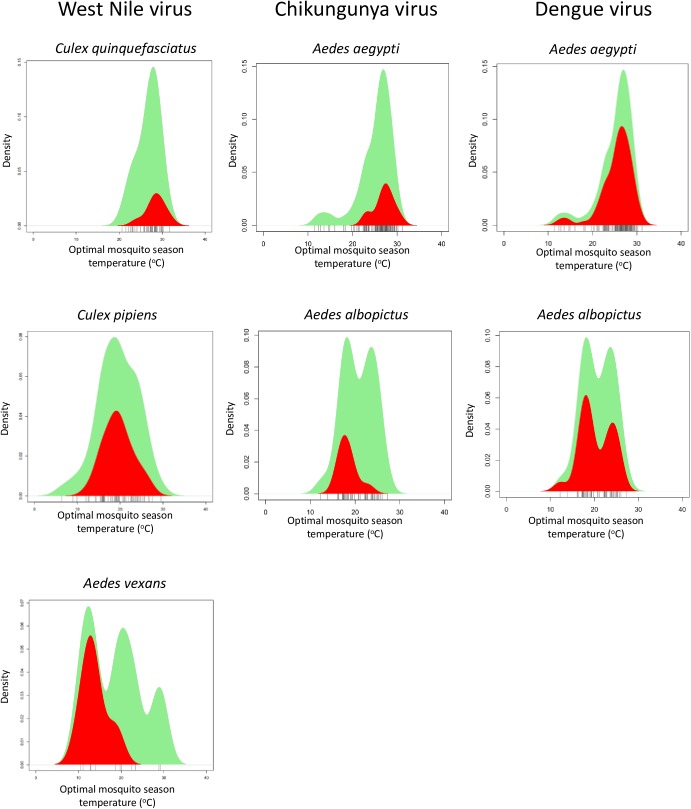
Temperature ranges of vectors and vector/virus co-occurrence.Kernel density estimations for the density of the different mosquitoes across their temperature ranges. The green area represents all single vector sub-countries, whilst the red area represents the density of sub-countries in which the relevant virus was also found. For single vector sub countries with or without virus/ single vector sub countries with virus only: chikungunya virus (Ae. aegypti n = 112/24, Ae. albopictus n = 48/9), dengue virus (Ae. aegypti n = 117/73, Ae. albopictus n = 48/24); West Nile virus (Ae. vexans n = 12/5, C. pipiens n = 63/25, C. quinquefasciatus n = 46/9). Grey ticks beneath the graph represent the actual OMS temperature of each of the sub-countries (with or without virus) described by the graph. Note: values of n for the same vector species but different viruses vary as a result of different lists of vector species resulting in different numbers of single-vector sub-countries.